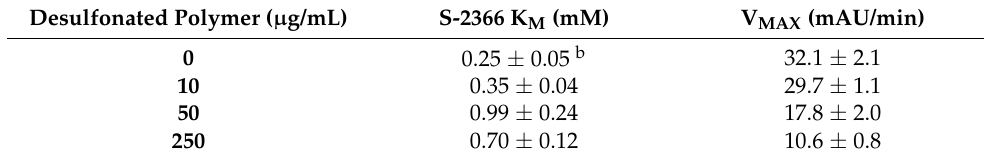
Table 6. Hydrolysis of the chromogenic substrate S ‐ 2366 by FXIa in the presence of desulfonated polymer a .